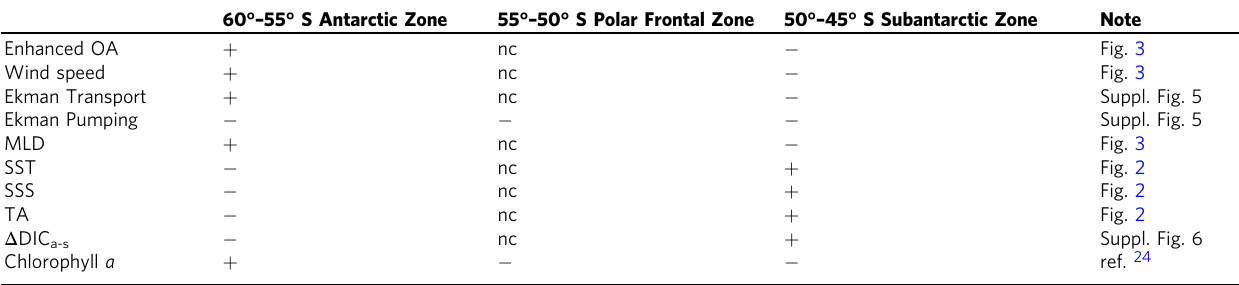
Table 1 Observed trend change of OA, wind speed, Ekman transport, Ekman pumping velocity, mixed layer depth (MLD), sea surface temperature (SST), salinity (SSS), total alkalinity (TA), dissolved inorganic carbon gains due to air-sea CO 2 exchange ( Δ DIC a-s ) and chlorophyll a in the three latitudinal bands of 60° – 55° S, 55° – 50° S, and 50° – 45° S during the 1991 – 2000 positive SAM